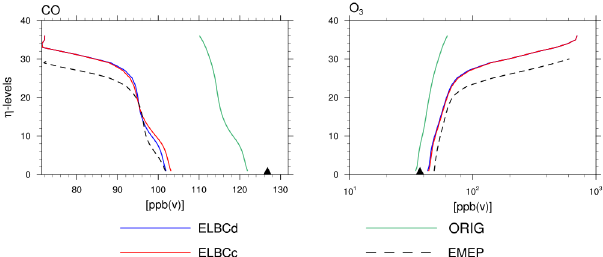
Figure 13. The 7-year average vertical profiles at the Mace Head station location for CO (to the left) and O 3 (to the right), for the MATCH results and EMEP. The average ground-based measure- ments at the Mace Head station is also shown as a black triangle. The levels correspond to η levels which varies with surface and model top pressure at each grid point and the pressure level 500hPa approximately corresponds η level no. 18.